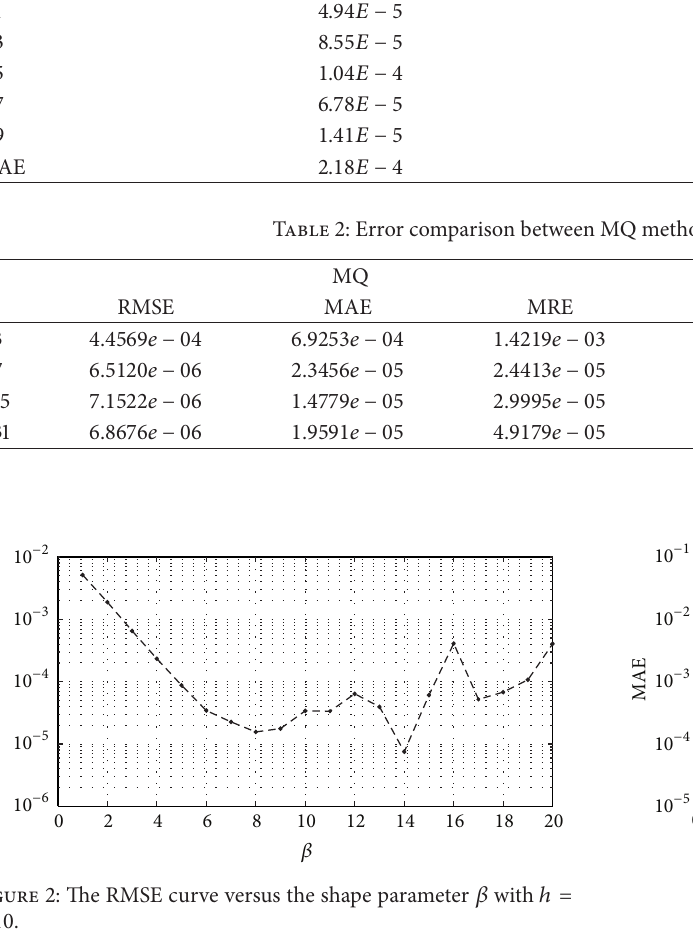
Figure 4: The maximum absolute error comparison among Haar, triangular, MQ, and Gaussian